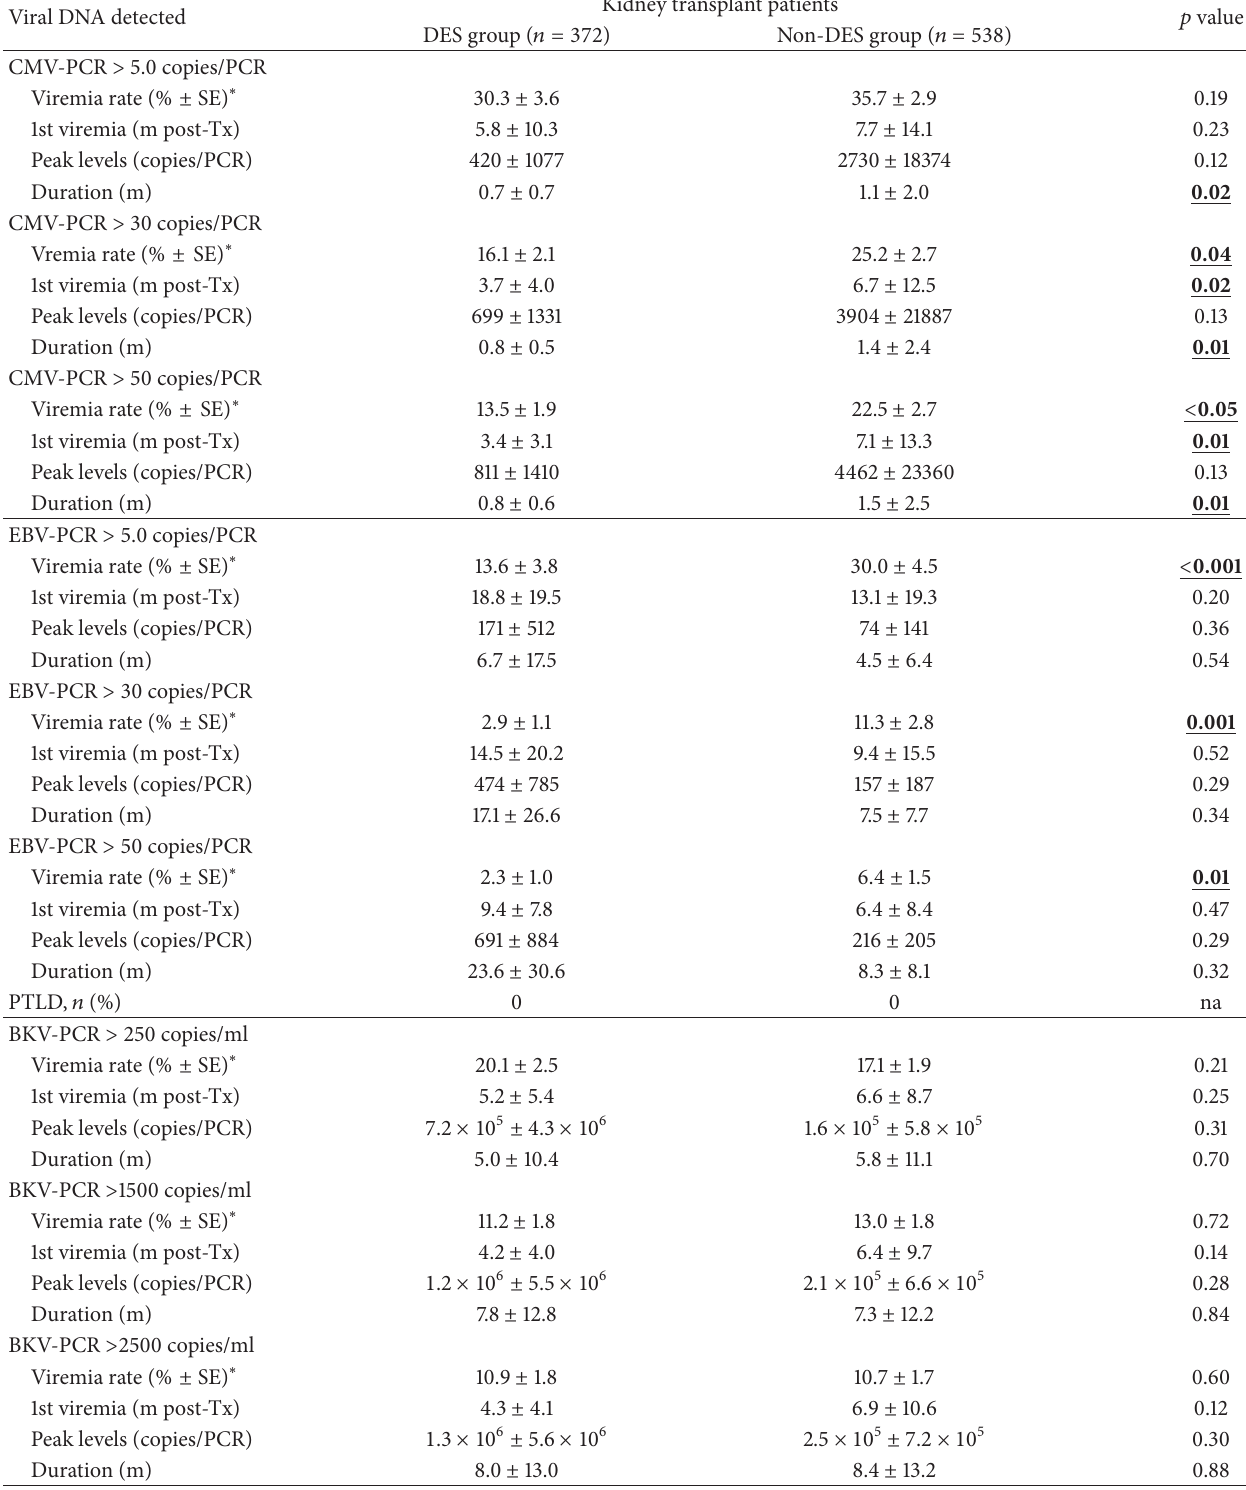
Table 2: CMV, EBV, and BKV viremia in DES and non-DES patients. Viral DNA